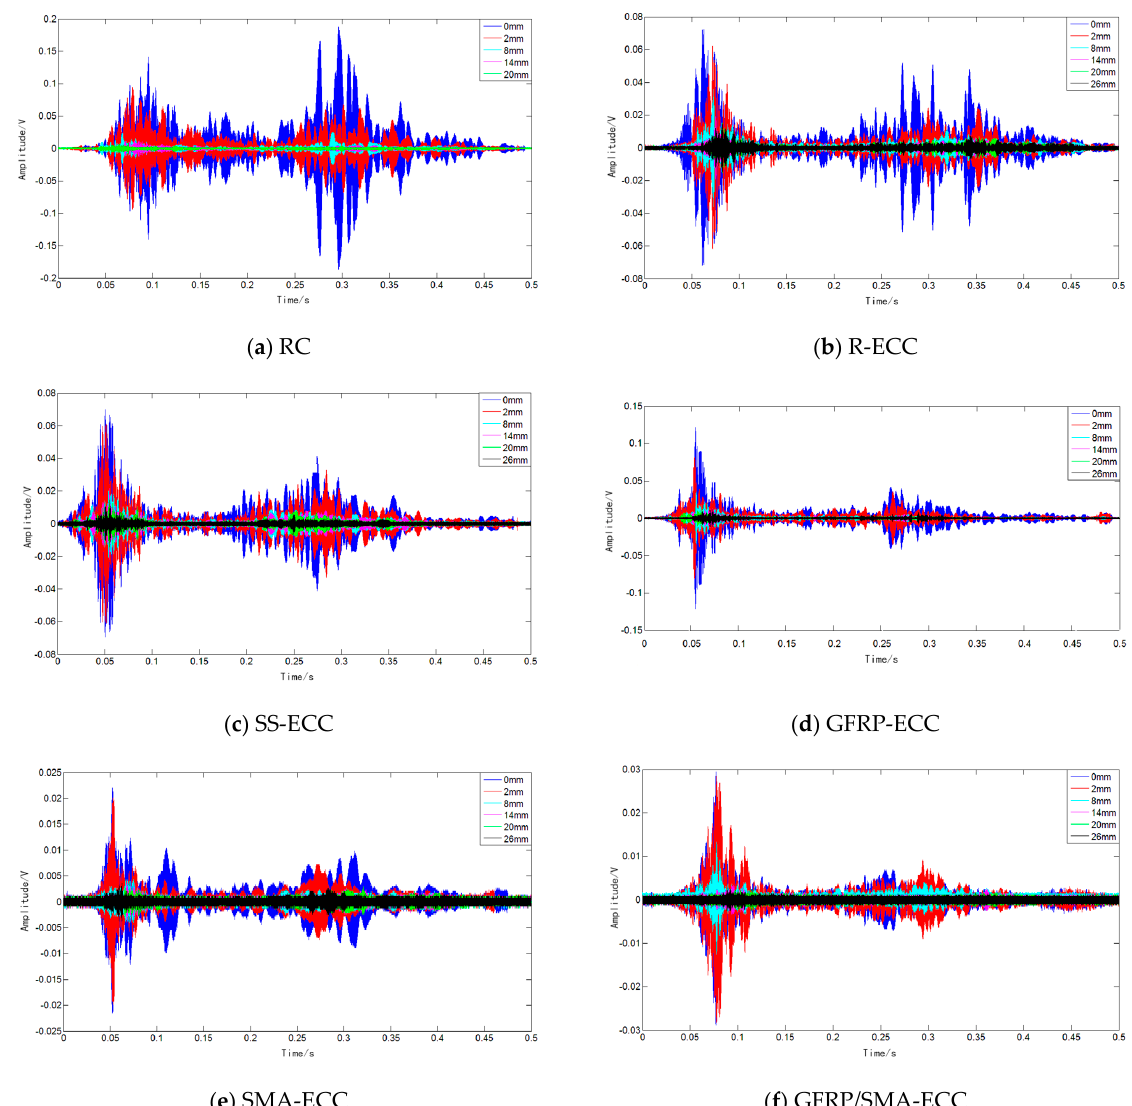
Figure 12. Time-domain